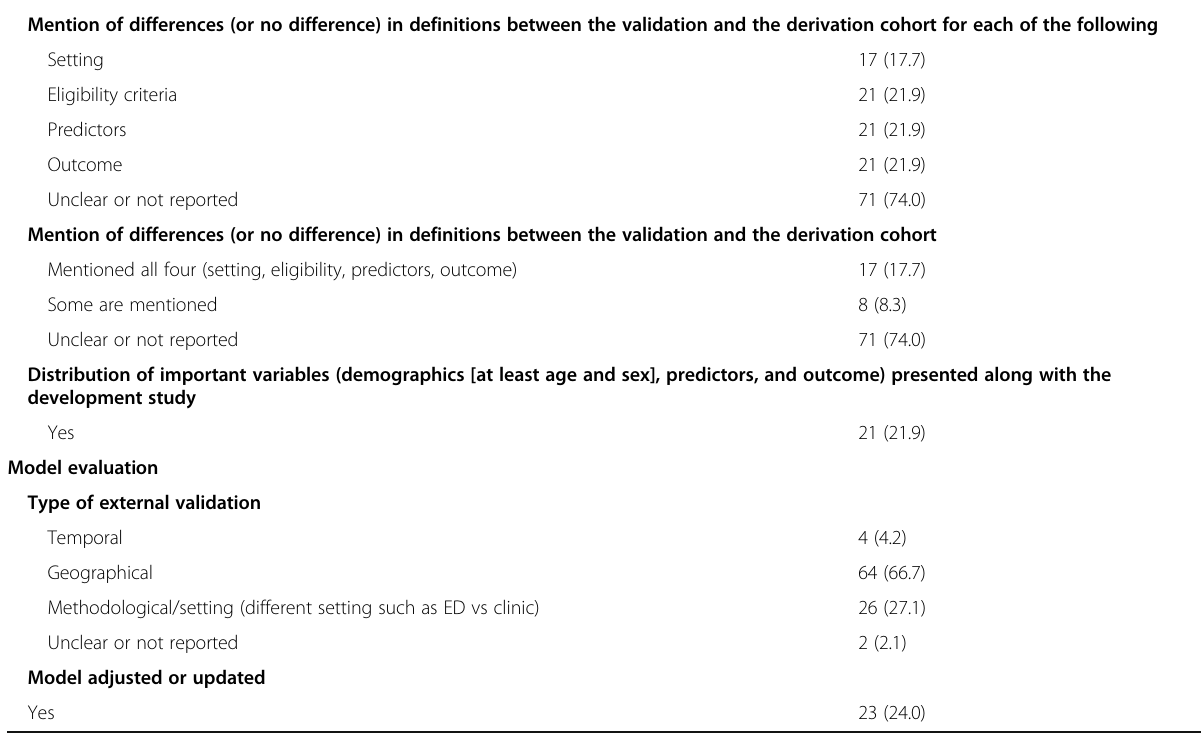
Table 3 Reporting of essential items applicable to validation studies only Characteristic Comparison with derivation